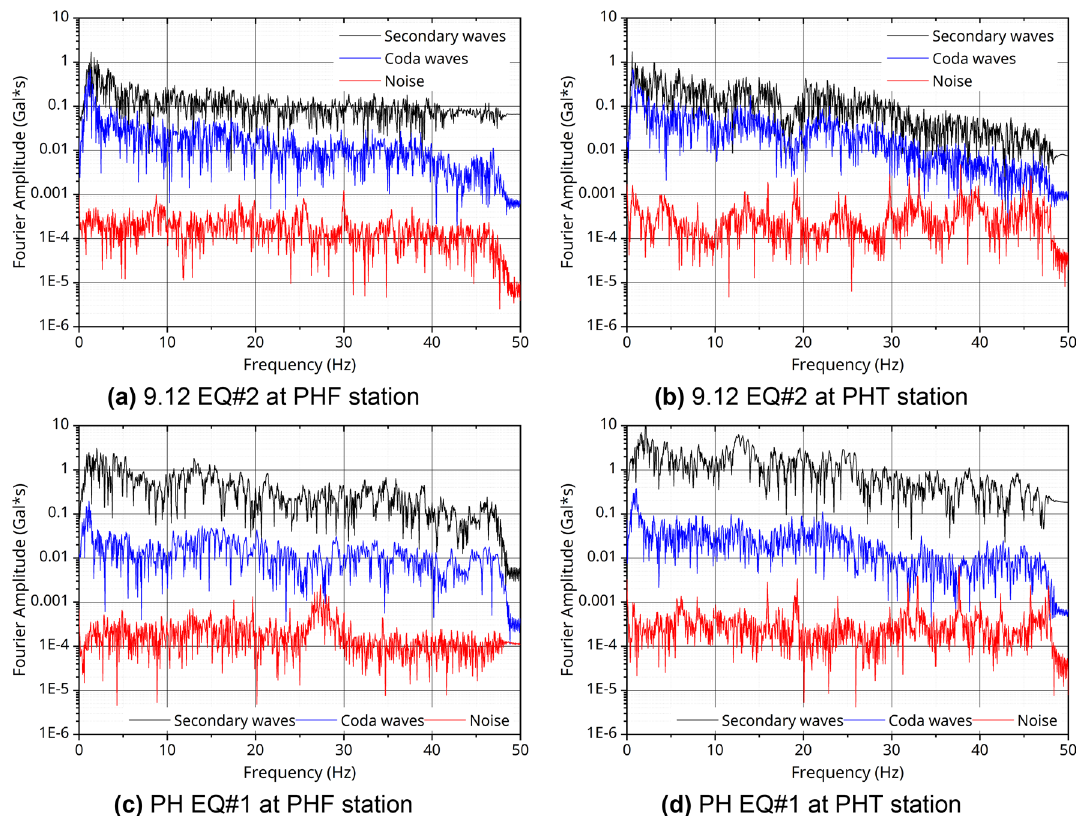
Figure 2. FFT analysis for Z-component of stations according to earthquakes (left: PHF, right: PHT).